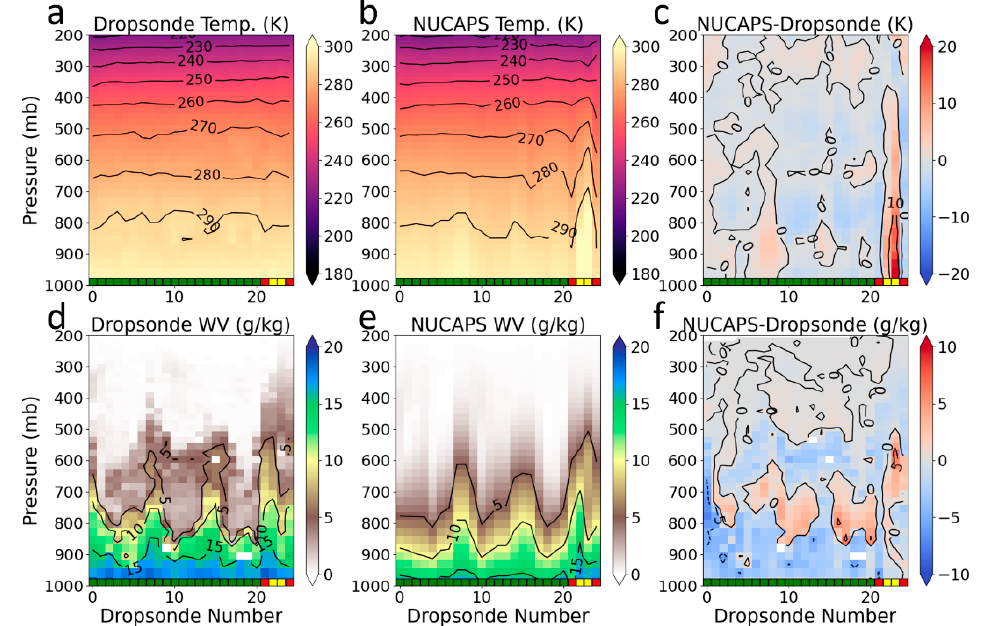
Figure 2. The top row shows the vertical pressure cross-sections (mb) for the ( a ) dropsonde temperature, ( b ) the NUCAPS temperature IR + MW retrieval from NOAA-20, and ( c ) the difference between ( a , b ). The bottom row shows ( d ) the dropsonde water vapor mixing ratio, ( e ) the NUCAPS water vapor IR + MW retrieval from NOAA-20, and ( f ) the difference between ( d , e ). Profiles shown are for the dropsonde collocations in Figure 1. The squares at the bottom of each plot represent the quality flag, as described in Figure 1.